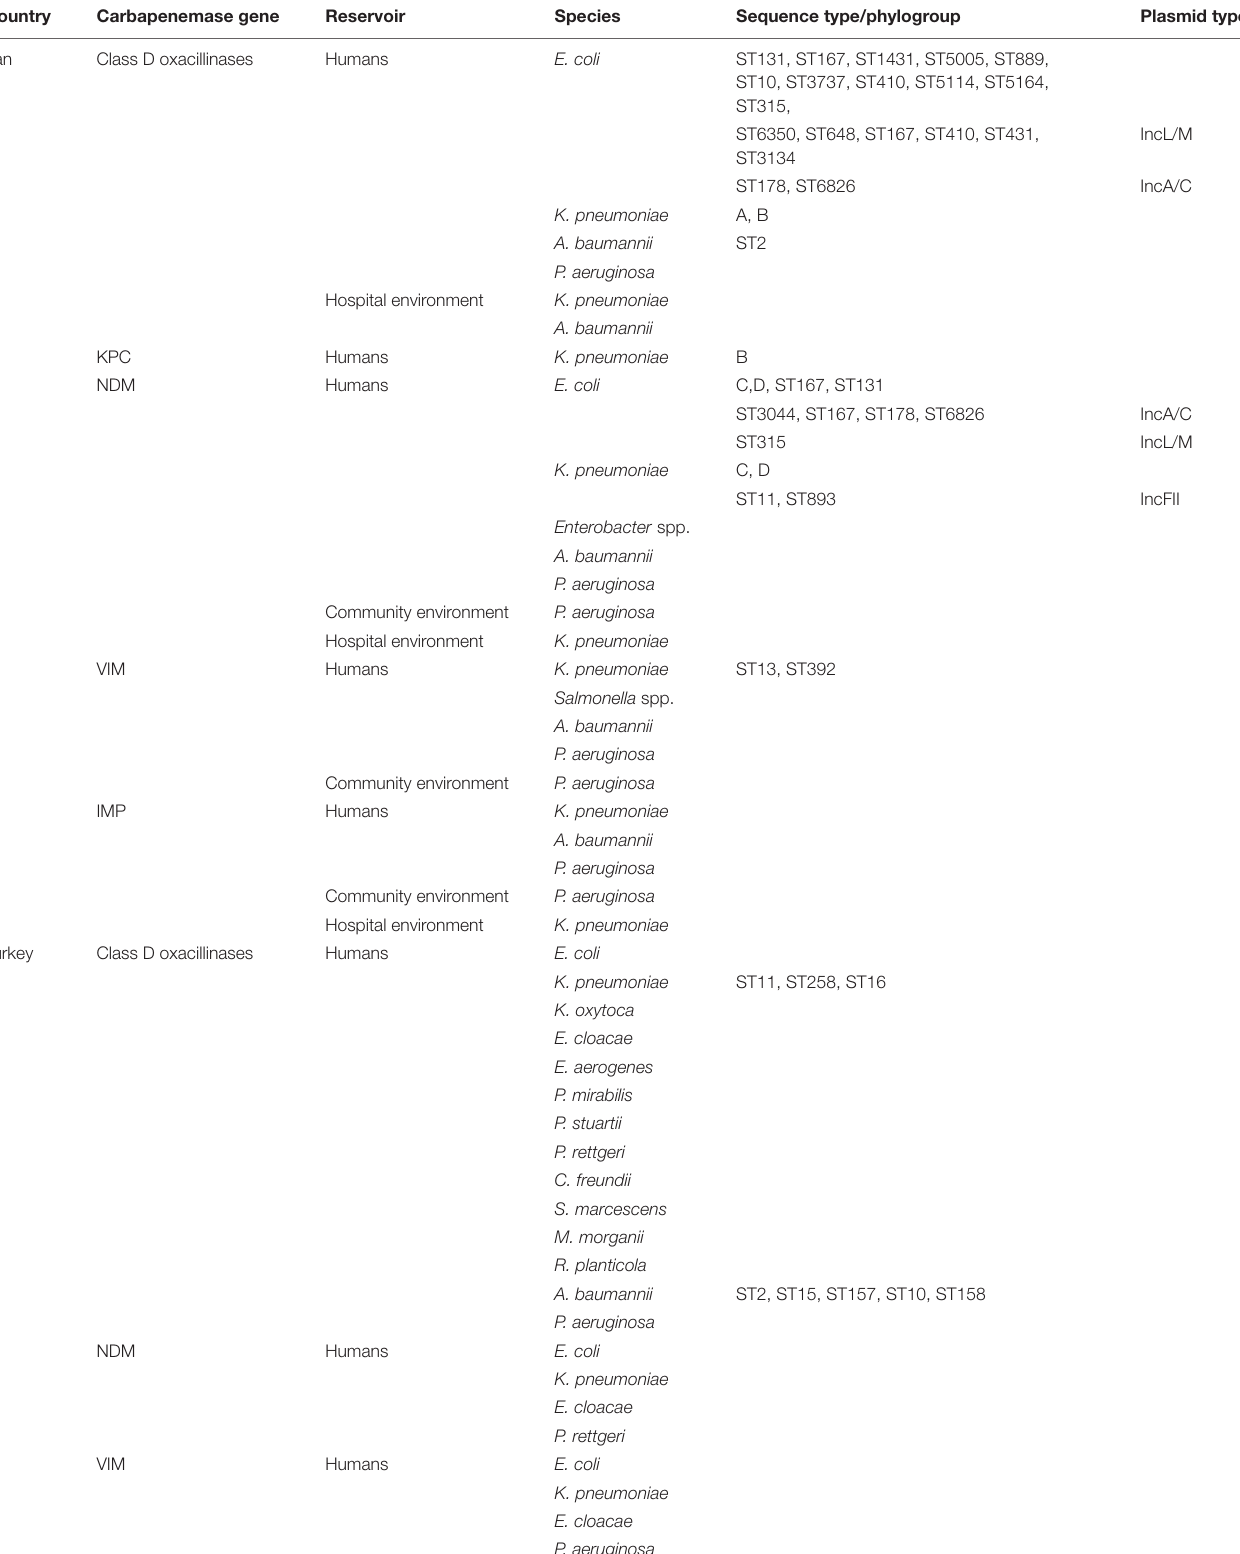
TABLE 2 | Sequence and plasmid types associated with carbapenemase genes in humans, animals, and environment in the Middle East. Country Carbapenemase gene